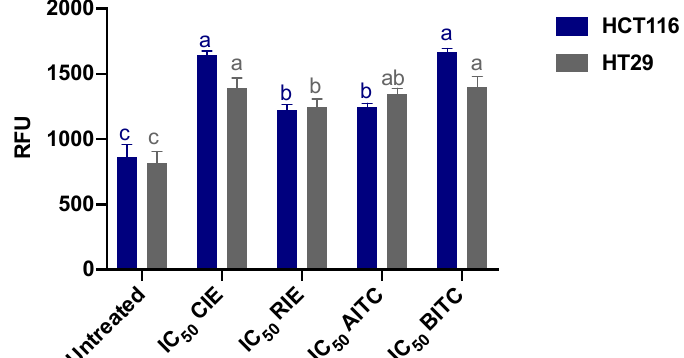
Figure 4. Intracellular reactive oxygen species (ROS) produced by HCT116 and HT29 cells after treatment with the half-inhibitory concentrations (IC 50 ) of cauliflower and radish isothiocyanate extracts (CIE and RIE), allyl isothiocyanate (AITC), and benzyl isothiocyanate (BITC). The results are the mean ± SD of three independent experiments in triplicate. Different letters express significant differences ( p < 0.05) by the Tukey–Kramer test for each cell line between treatments. Untreated cells corresponded to MEM-only-treated cells. RFU: Relative fluorescence units.